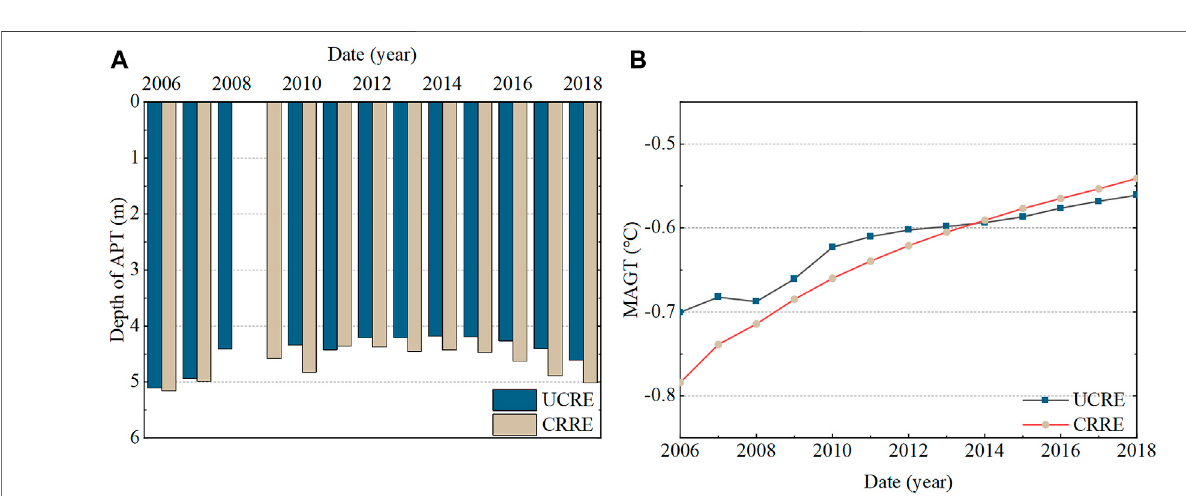
FIGURE 6 | Variations in the APT (A) and MAGT (B) of the